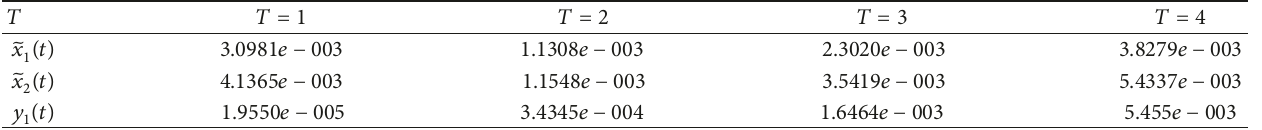
Table 1: The error of numerical solutions.